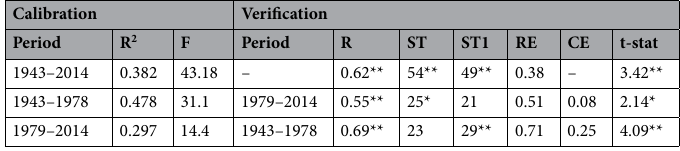
Table 2. Statistics of split calibration-verification test results. **p < 0.01, *p < 0.05.